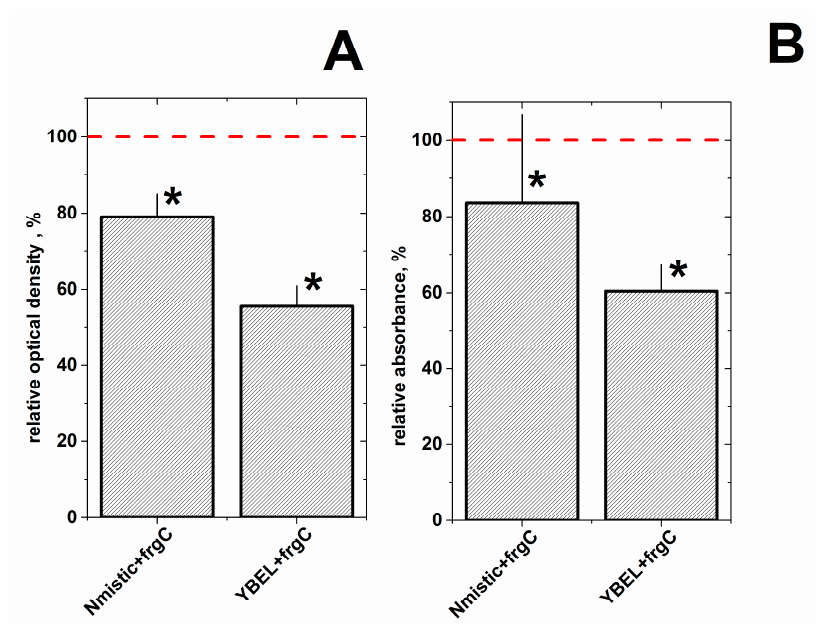
Figure 6. Estimation of frgC 91–220 surface enrichment by partial trypsin digestion of BLR(DE3) spinycterins followed by PAGE ( A ) and ELISA ( B ) analysis.